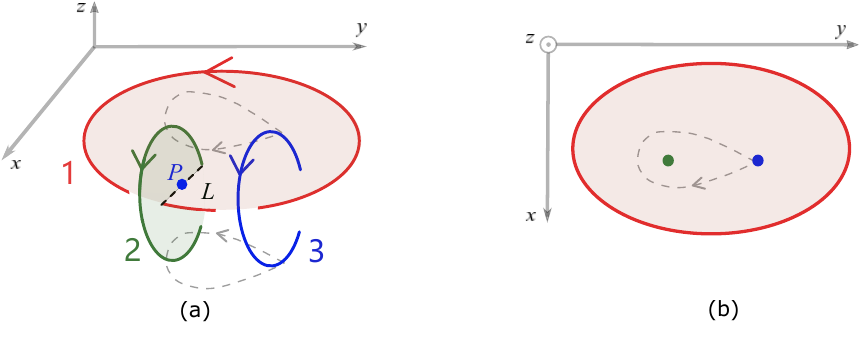
Figure 6 . 3 -loop braiding described by AAdA term in 3 D space. (a) The configuration of 3 - loop braiding described by A 1 A 2 dA 3 term. For this 3 -loop braiding, its phase shift is related to # (Ω 1 ∩ Ω 2 ∩ σ 3 ) as indicated in eq. (2.50). This linking number can be calculated via